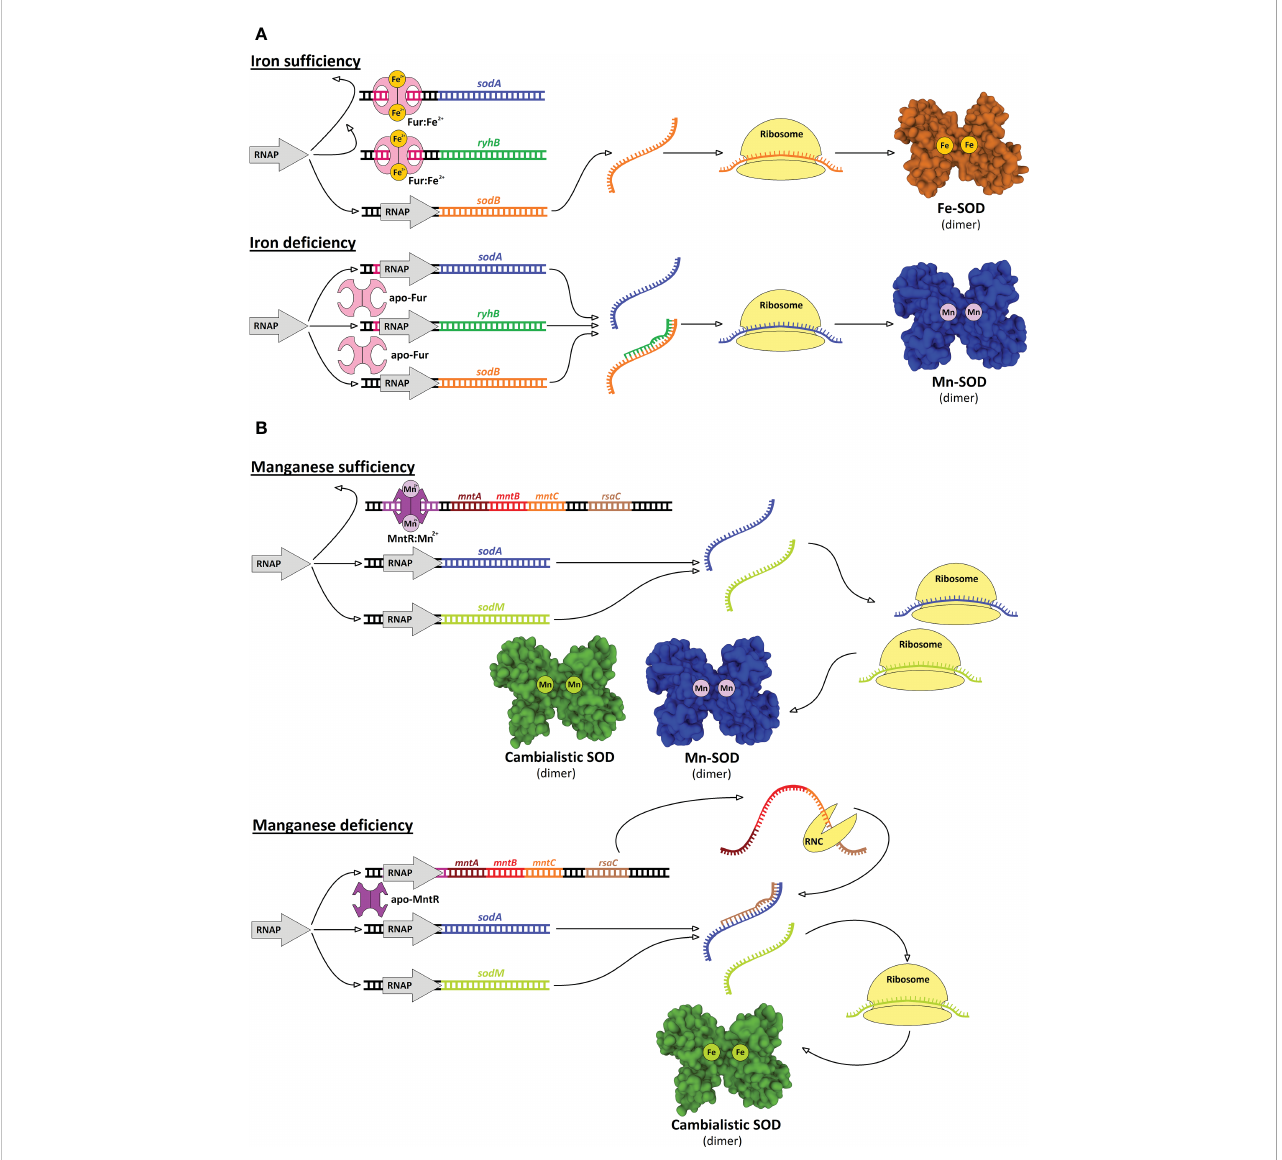
FIGURE 7 Two distinct mechanisms based on transcriptional and post-transcriptional regulatory mechanisms controlling expression of SODs. (A) In E coli and several other Gram-negative bacteria, small RNA RyhB and availability of iron play a central role in control of alternate expression of Fe-SOD and Mn- SOD. When iron is suf fi cient, Fur repressor loaded with iron inhibits expression of ryhB gene and sodA encoding Mn-SOD, while sodB gene encoding Fe-SOD is transcribed by RNA polymerase (RNAP) and Fe-SOD is produced. When iron is at scarce, apo-Fur does not repress ryhB and sodA , hence Mn- SOD is produced. Simultaneously, transcribed RyhB binds to sodB transcript and blocks its translation, thus, Fe-SOD is not produced (Masse and Gottesman, 2002; Vecerek et al., 2003). (B) In Gram-positive S. aureus small RNA RsaC and manganese availability control expression of sodA and sodM genes. When manganese is suf fi cient, MntR repressor loaded with manganese inhibits expression of mntABC operon including rsaC gene, while both sodA and sodM genes, encoding Mn-SOD and cambialistic SOD, respectively, are expressed and respective SODs are produced. When manganese is